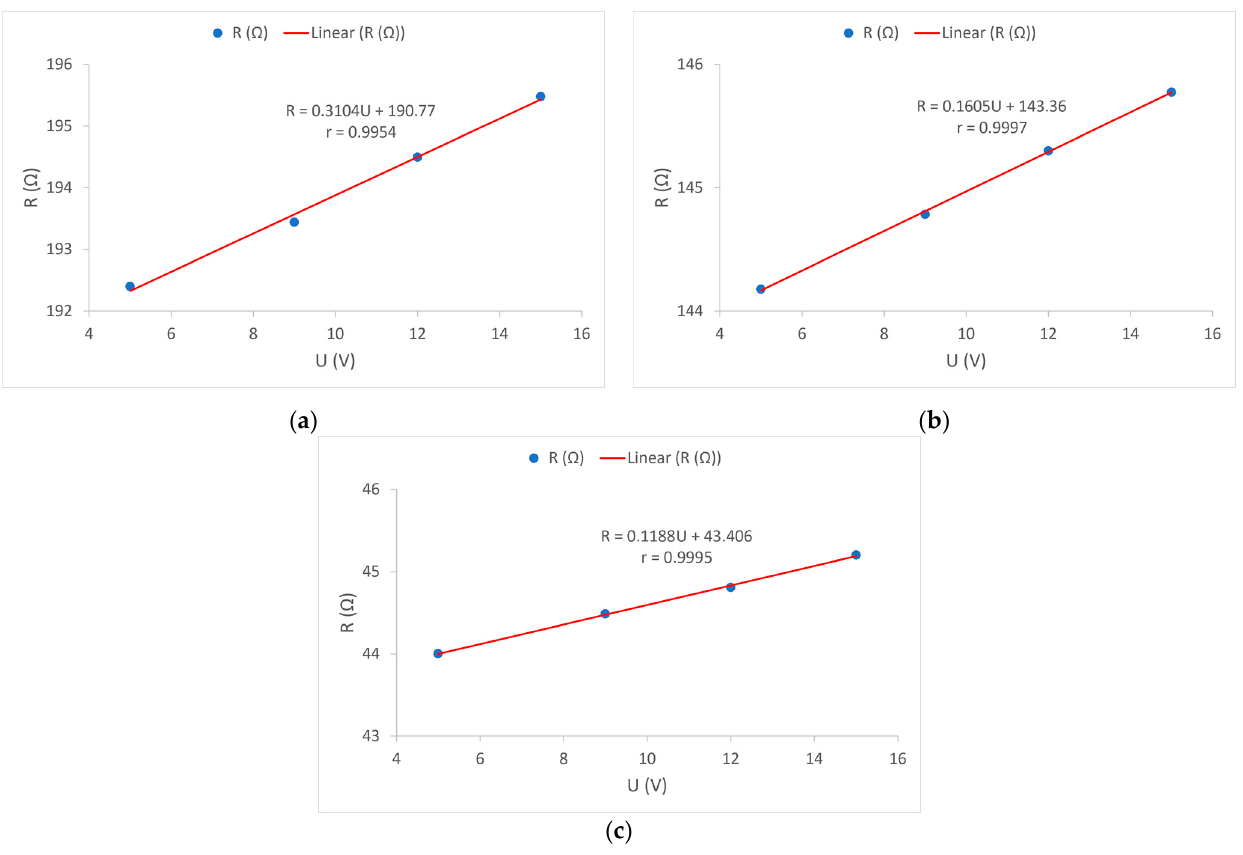
Figure 12. Dependence of electrical resistance R of electrically conductive yarns on supply voltage U : ( a ) Sample 1; ( b ) Sample 2; ( c ) Sample 3.